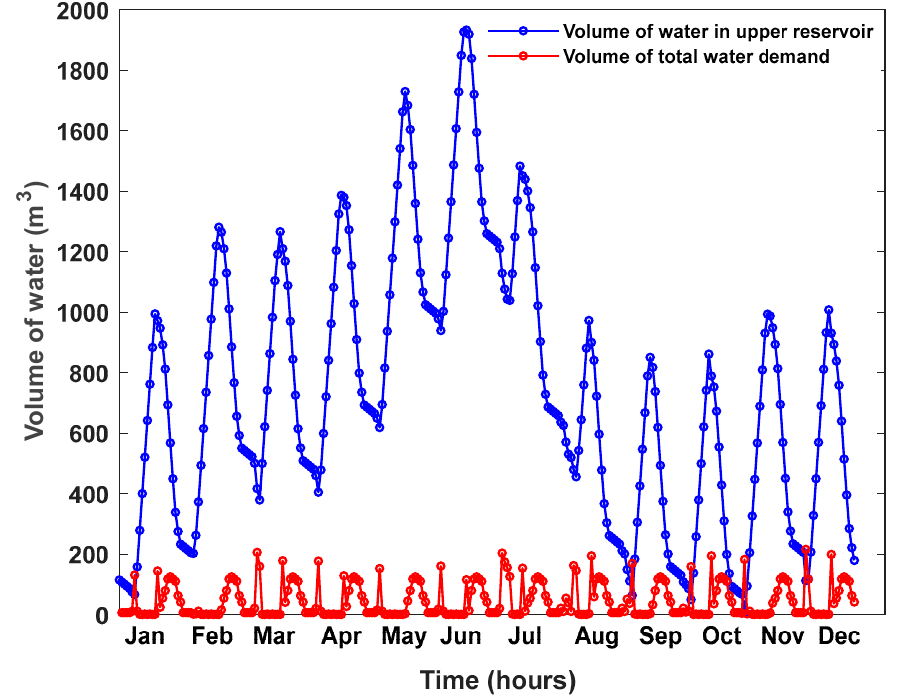
Figure 14. Comparison between the water supply and the water demand at any time of the year.